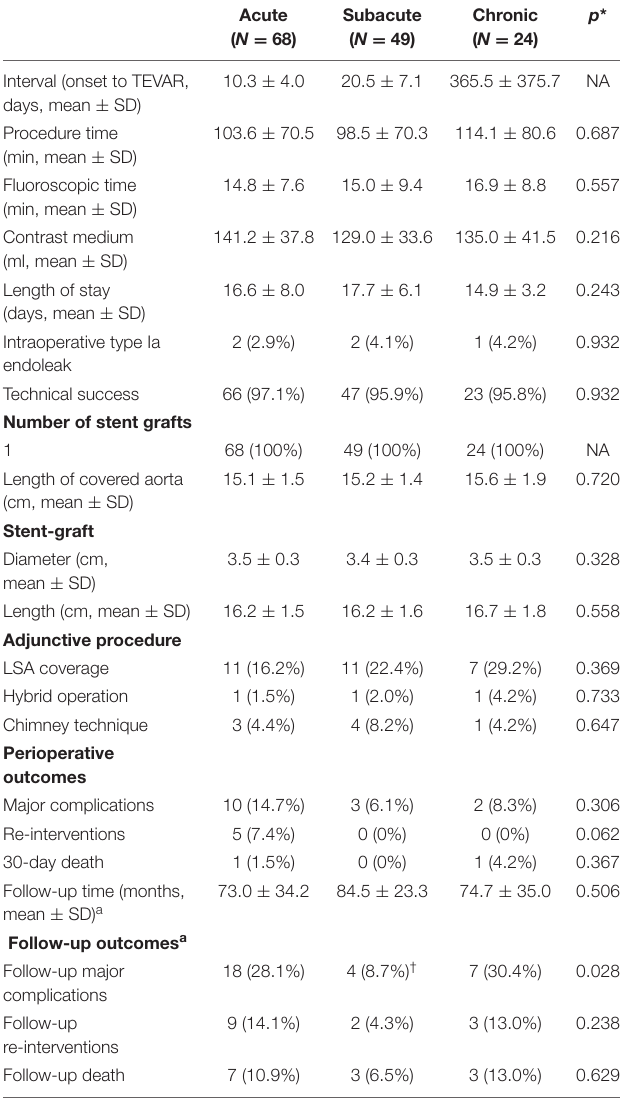
TABLE 2 | Procedural details and clinical